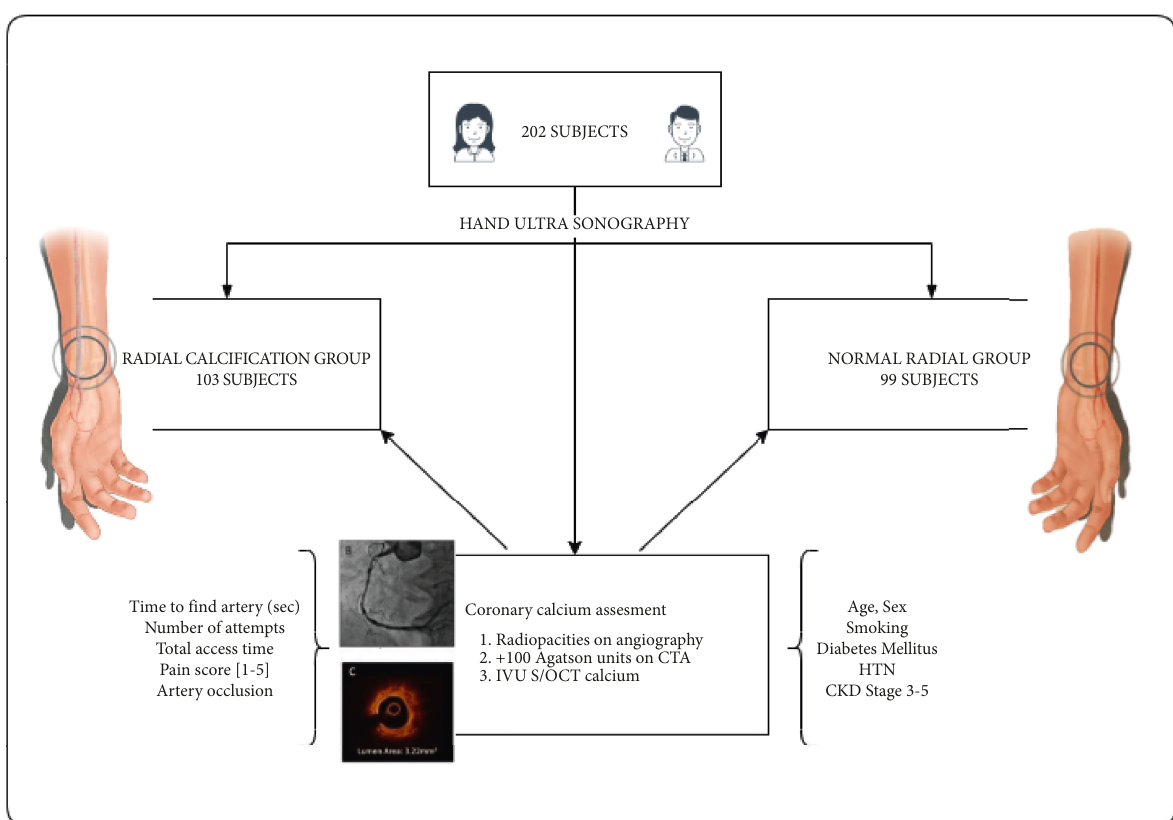
Figure 1: Study design and patient selection. Inclusion in each group was done blindly and